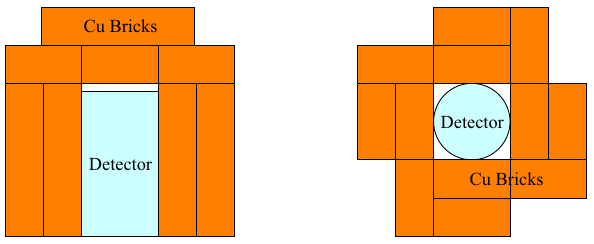
Fig. 1 Schematic diagram of placement of OFHC copper bricks in spectrometer: right view (left) and top view